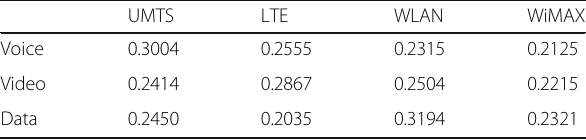
Table 17 User preferences for candidate networks for different